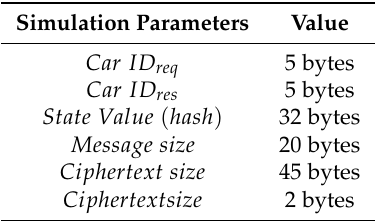
Table 3. Simulation